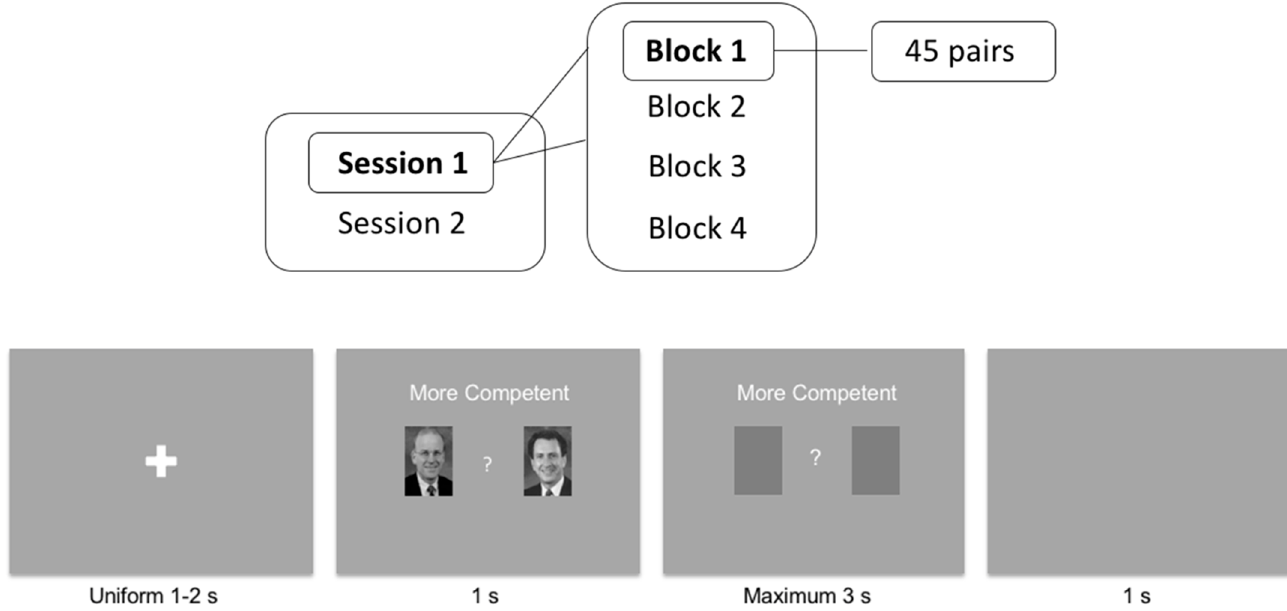
Fig 1. Experiment procedure and image display screens. (a) The schematic diagram of the full experiment. (b) Exampleof image display screens in the competenceevaluation block. At the beginningof each block, there were instructions on the screen indicating which trait the participant was asked to evaluate. Then for each pair of candidates, participants first focused on the cross of the fixation screen which lasted for 1–2 seconds; then the images of the pair of candidates were up for 1 second; participants could make a decisionas soon as the images appeared;after the images disappeared,participants had a maximum of 3 seconds to enter their choice. As soon as a valid key was pressed (i.e., press “A” if their choice was the candidateon the left and press “L” if their choice was the candidate on the right), a grey screen was up for a 1 second inter-stimulusinterval.